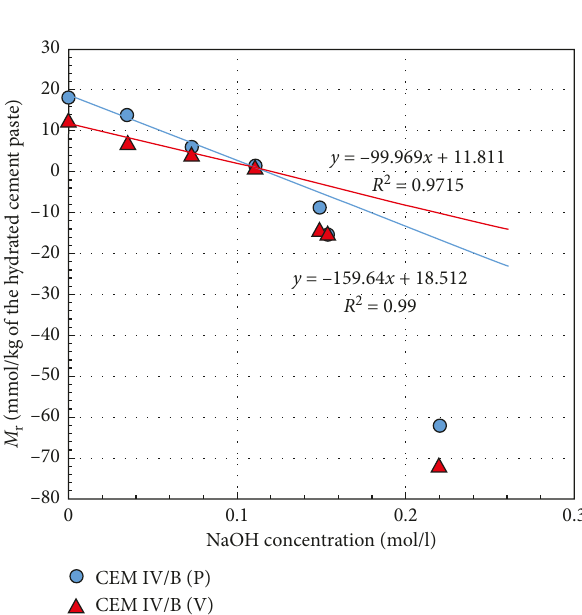
Figure 3: Relationship between M